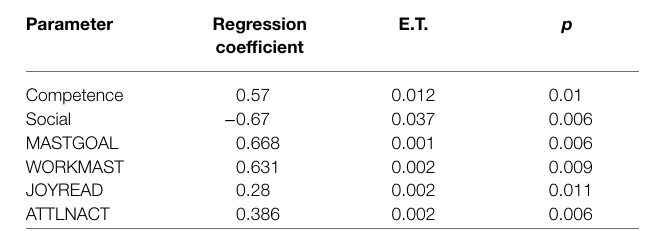
TABLE 6 | Results (regression coefficients and significant effects) for academic factor.